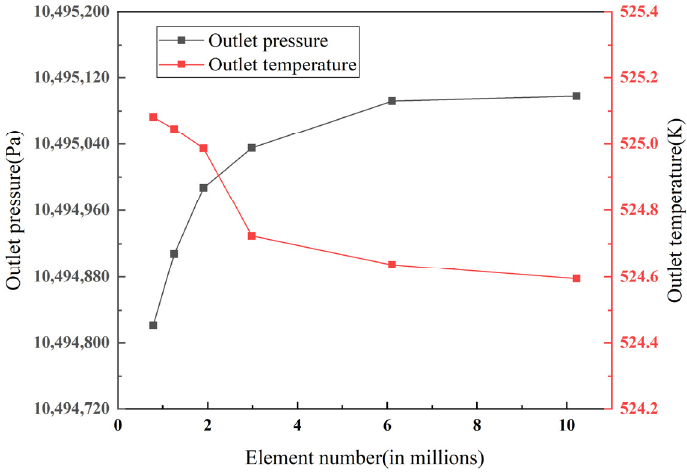
Figure 2. PCHE grid independence verification.